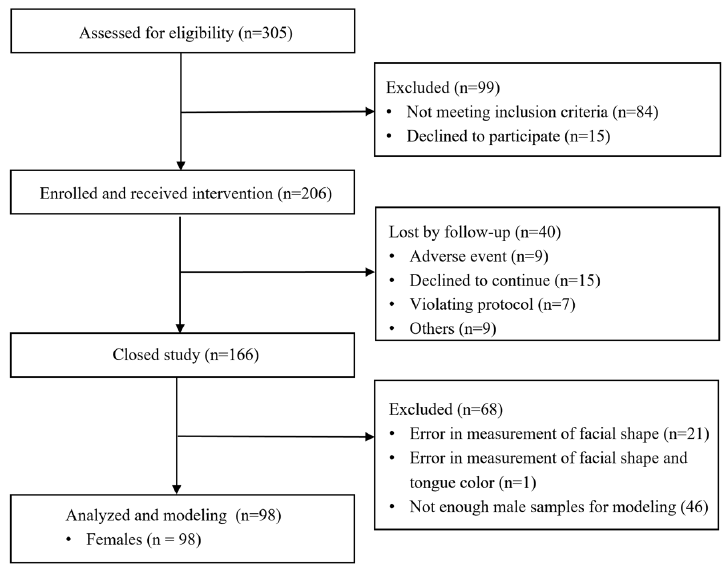
Figure 1. Sample selection procedure.